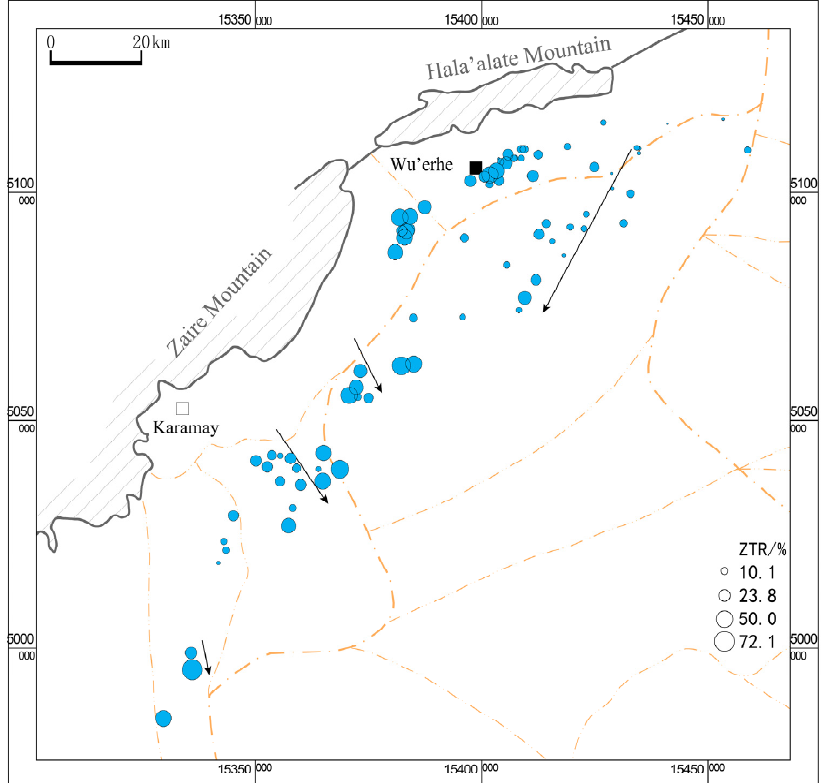
Figure 8. Spatial distribution of the zircon-tourmaline-rutile (ZTR) index of the Lower Wuerhe For- mation in the Mahu-Zhongguai area. Formation in the Mahu-Zhongguai